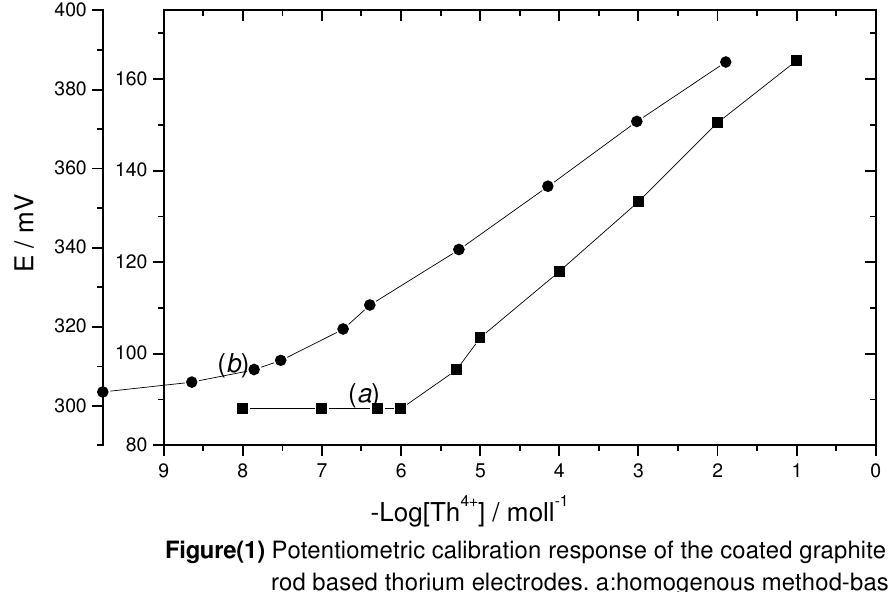
Figure(1) Potentiometric calibration response of the coated graphite rod based thorium electrodes. a:homogenous method-based ionophore and b: solid-solid reaction